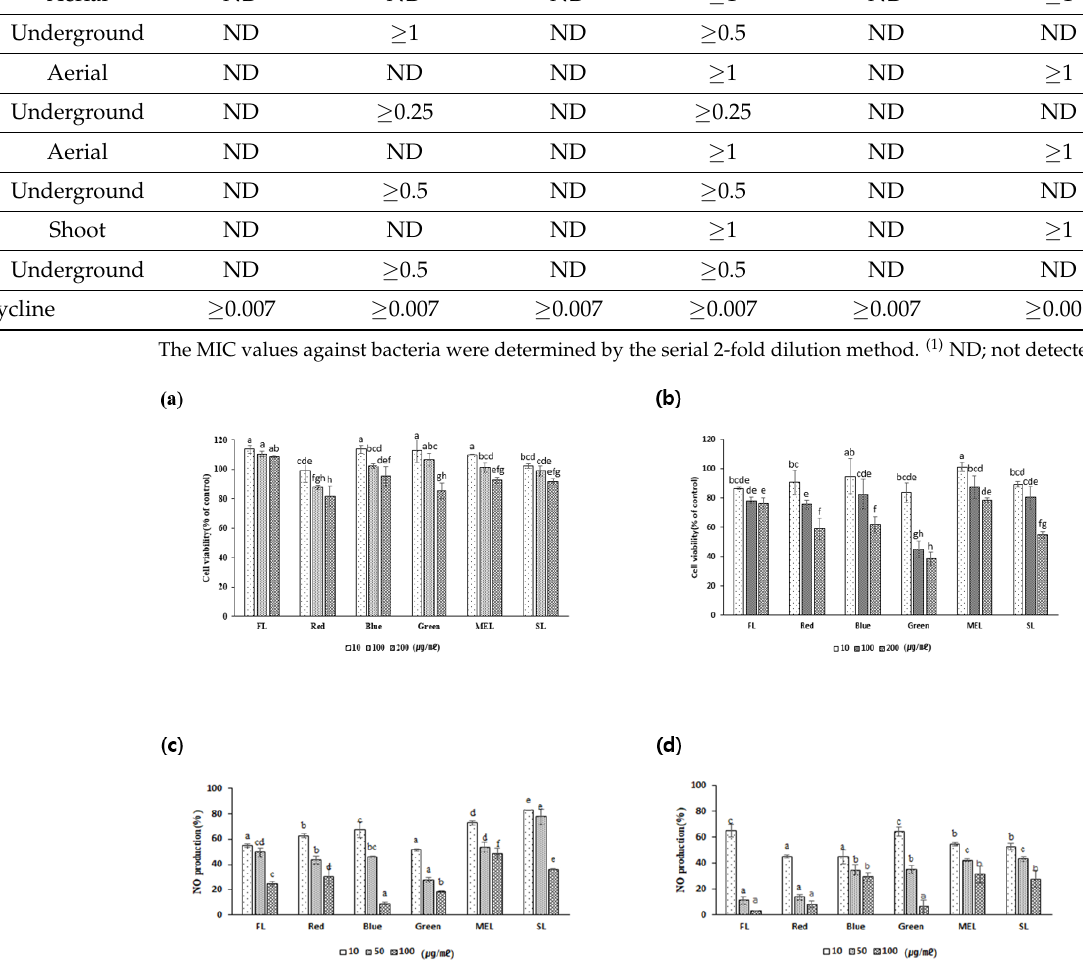
Figure 5. Cell viability ( a , b ) by MTT assay and NO production ( c , d ) in LPS-induced Raw 264.7 cell with Dachul extracts. ( a , c ) aerial part of A. macrocephala , ( b , d ) underground part of A. macrocephala. Significance was indicated with different letters according to statistical analysis.